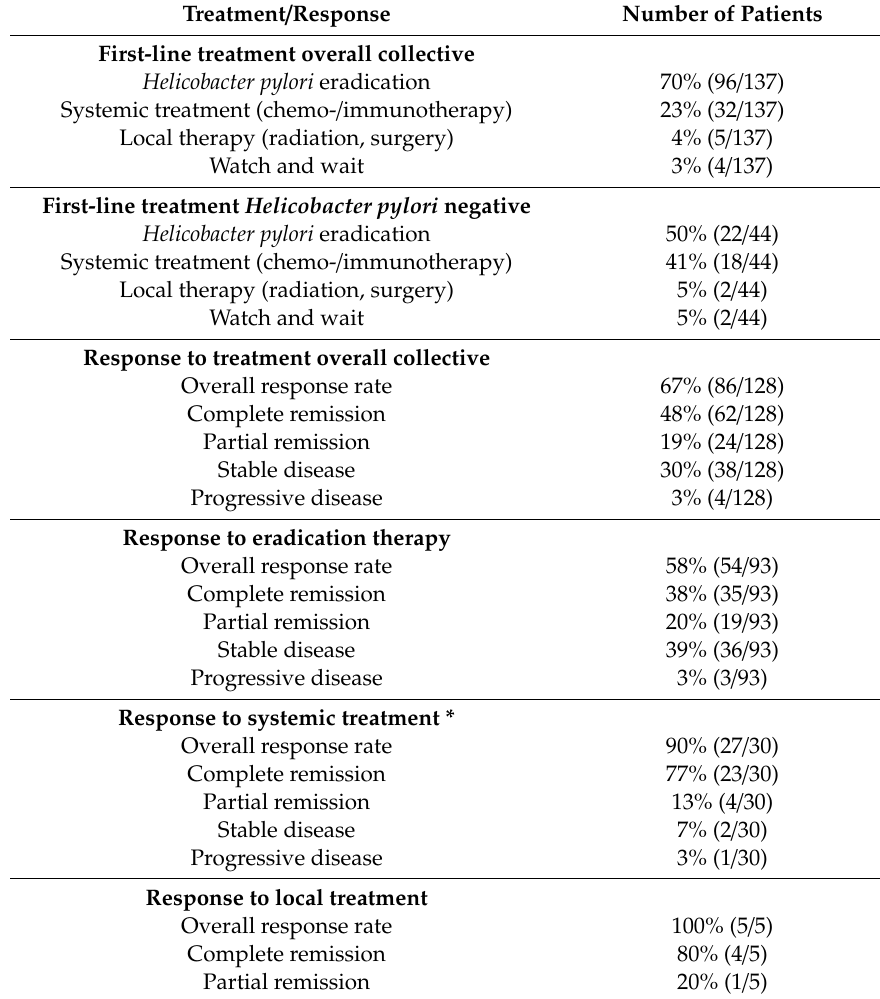
Table 2. First-line treatment characteristics and response data in gastric MALT lymphoma patients ( n =